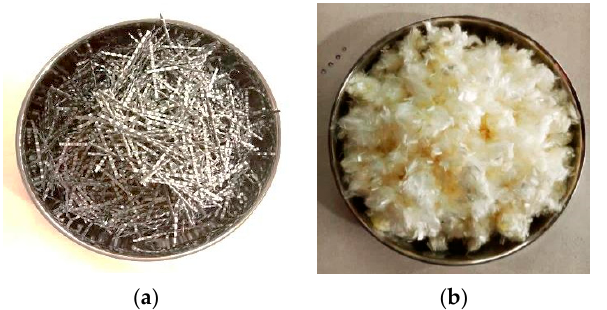
Figure 4. ( a ) waste ceramic cement (C WC )—75 μ m, ( b ) waste ceramic sand (S WC )—4.75 mm, ( c ) waste